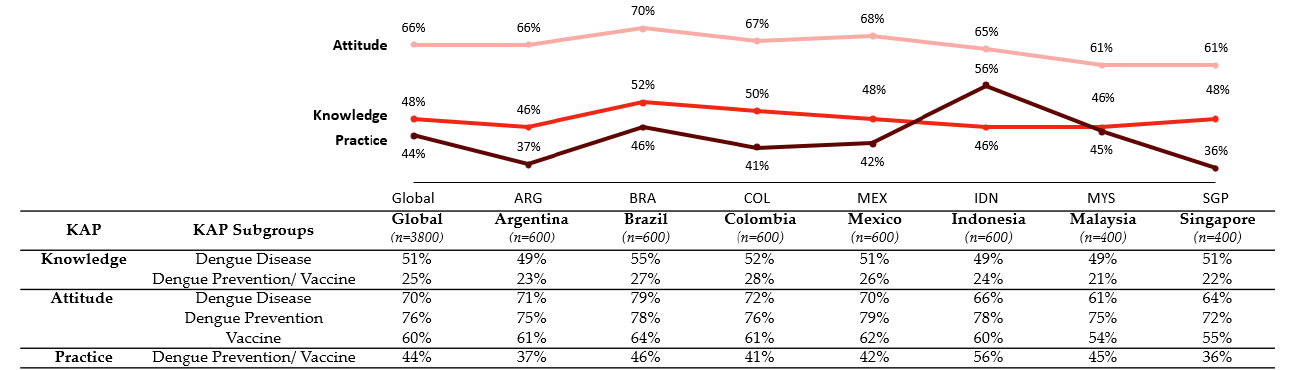
Figure 2. Knowledge, Attitudes, and Practices overall composite score and individual factor scores globally and by country.